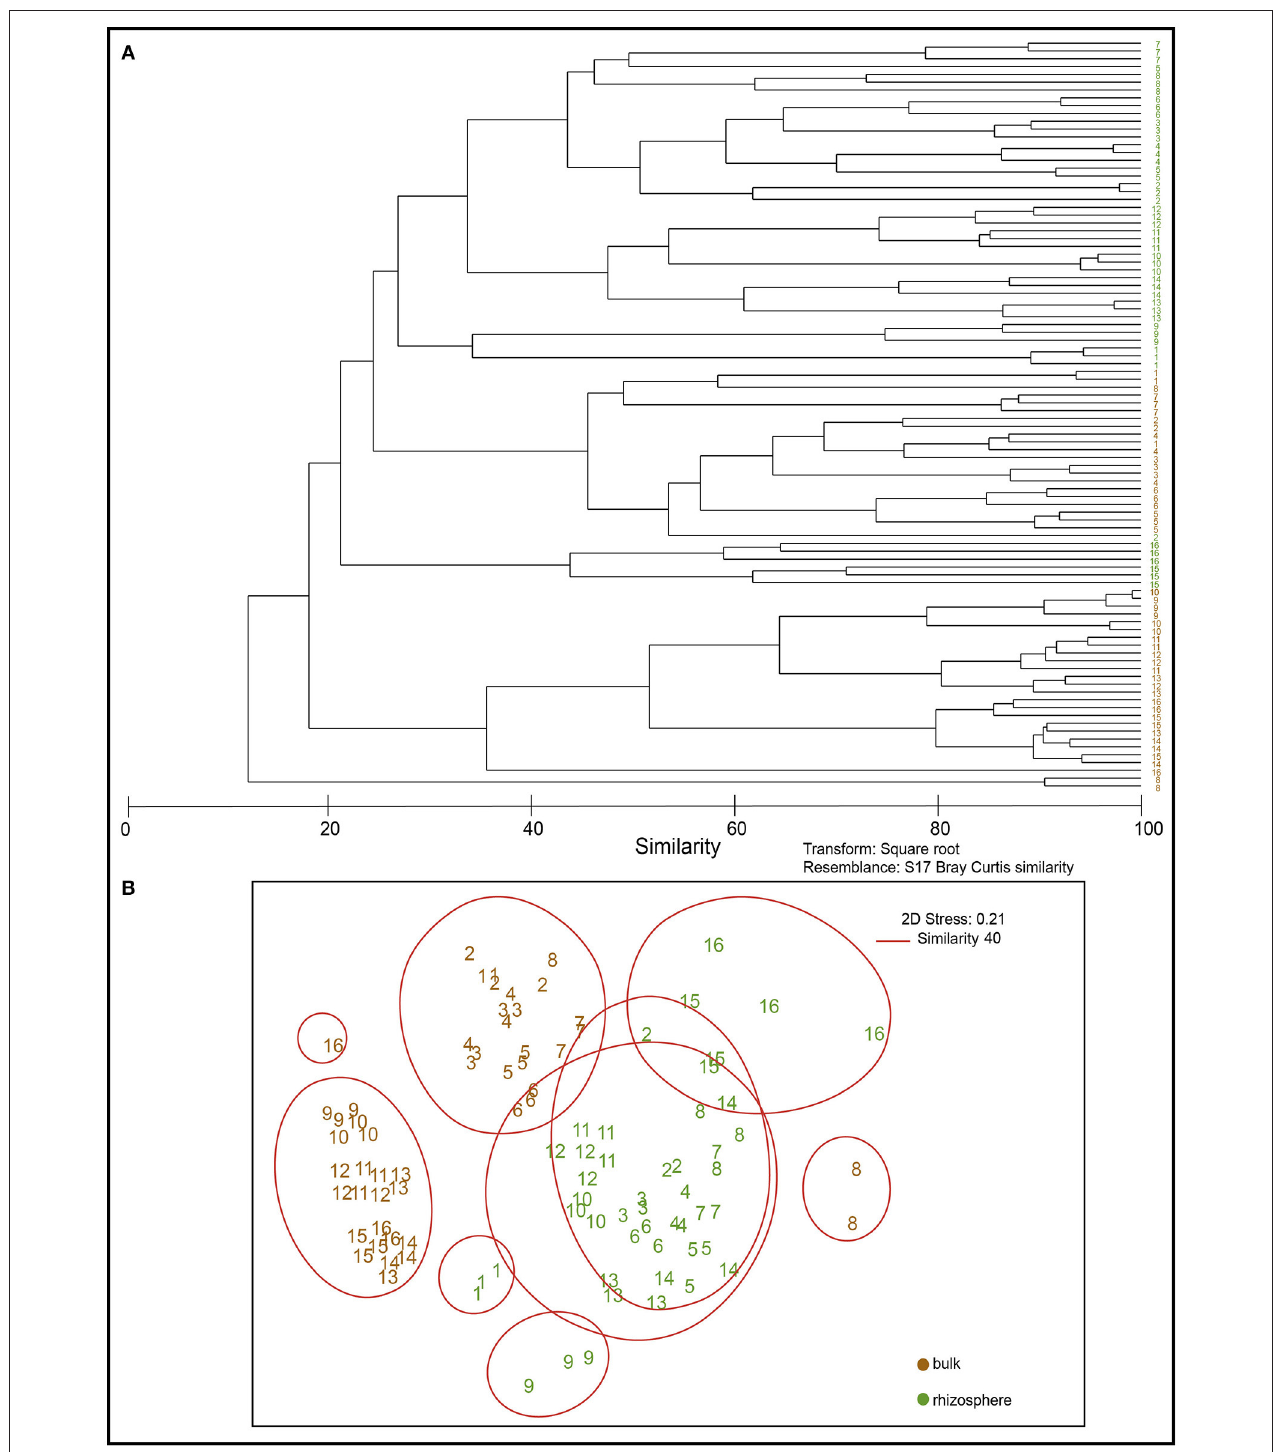
FIGURE 3 | Dendogram of DGGE profiles (A) and non-metric Multidimensional Scaling (NMDS) based on denaturing gradient gel electrophoresis (DGGE) profiles of bacterial communities present in bulk (brown) and rhizosphere (green) soil samples (B) .